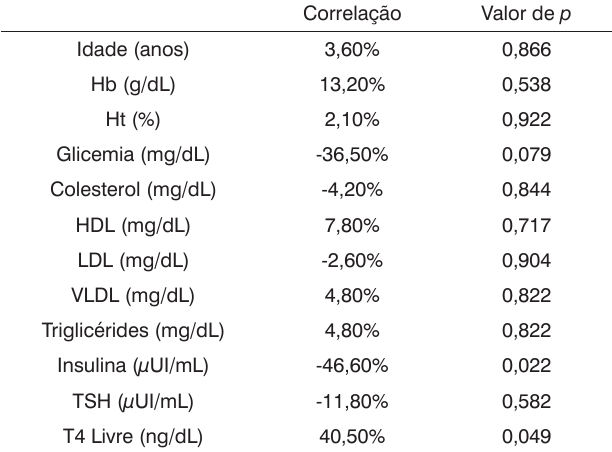
Tabela 2. Correlação das variáveis com a gravidade da